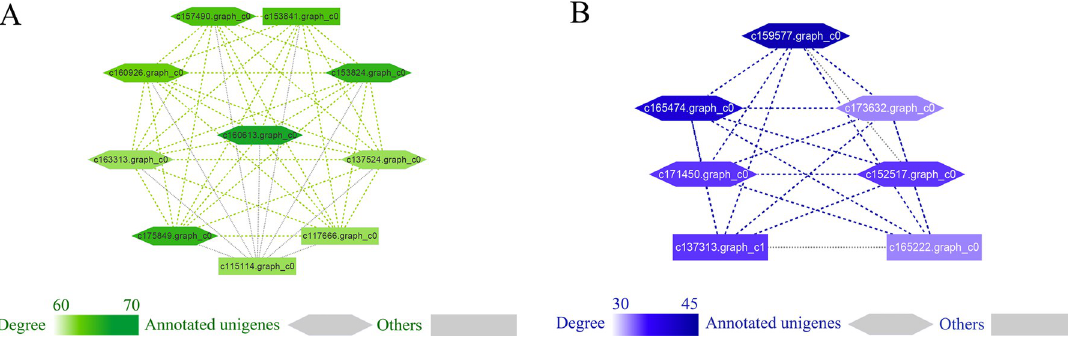
Fig 7. Hub gene visualization of the MEgreenyellow and MEmidnightblue modules associated with OY. A Ten hub genes from MEgreenyellow module were included in the Cytoscape-generated diagram. B Seven hub genes of the MEmidnightblue module were included in the Cytoscape-generated diagram. Darker color indicates greater degree value. The highlighted dotted line indicates a gene with edge weights > 0.02.